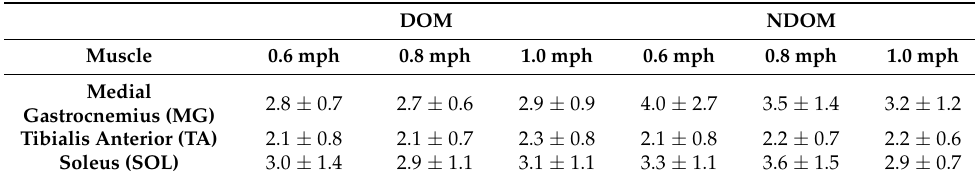
Table 1. Lower body electromyography (mV) signals standardized to BW ( n = 12). Data are presented as mean ±